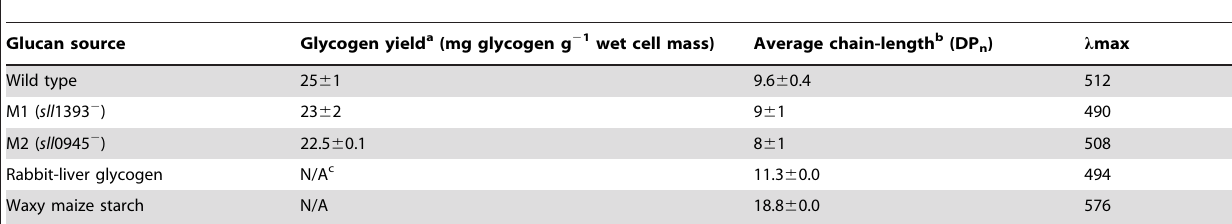
Table 3. Effects of sll 1393 and sll 0945 deletions on glycogen accumulation and structure, using commercial rabbit-liver glycogen and waxy maize starch for comparison.